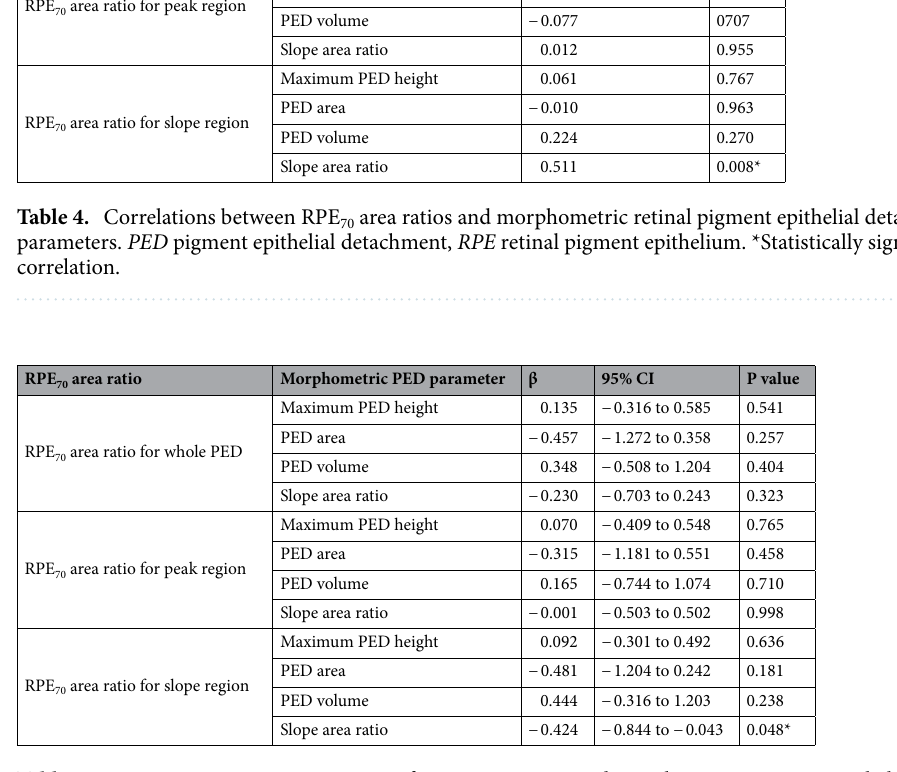
Table 5. Covariance parameter estimates of RPE 70 area ratios and morphometric pigment epithelial detachment parameters. CI confidence interval, PED pigment epithelial detachment, RPE retinal pigment epithelium. *Statistically significant